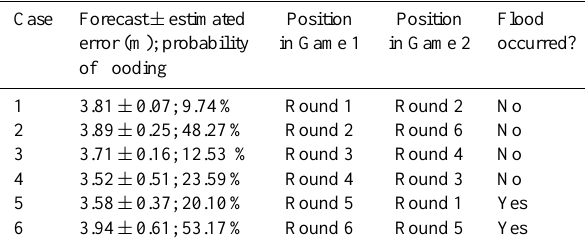
Table 1. Cases presented to participants with indication of the posi- tion in each game (round) and the occurrence or not of a flood. The level of flooding was set to